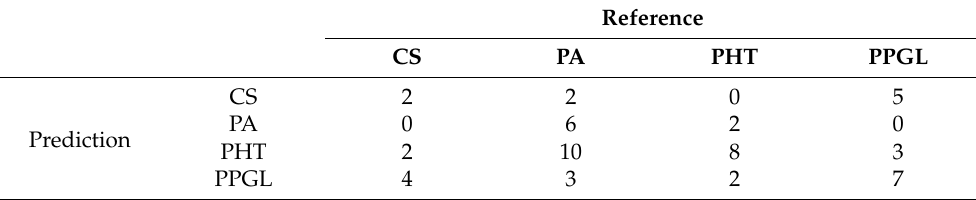
Table A10. Confusion matrix showing the actual and predicted labels for ALL vs.